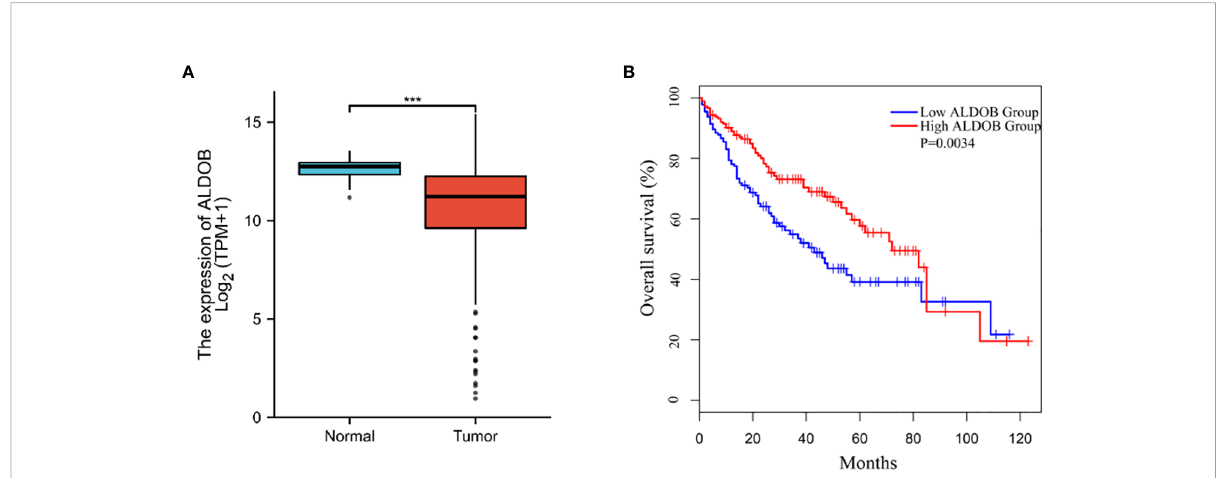
FIGURE 1 Down-regulation of ALDOB in human HCC and predicts poor prognosis. (A) ALDOB expression was signi fi cantly reduced in HCC compared to normal tissue. (B) Kaplan – Meier curve showed the correlation between ALDOB expression and overall survival of HCC patients analyzed using GEPIA. ALDOB with lower expression in the HCC samples had corresponding lower survival. ***P values<